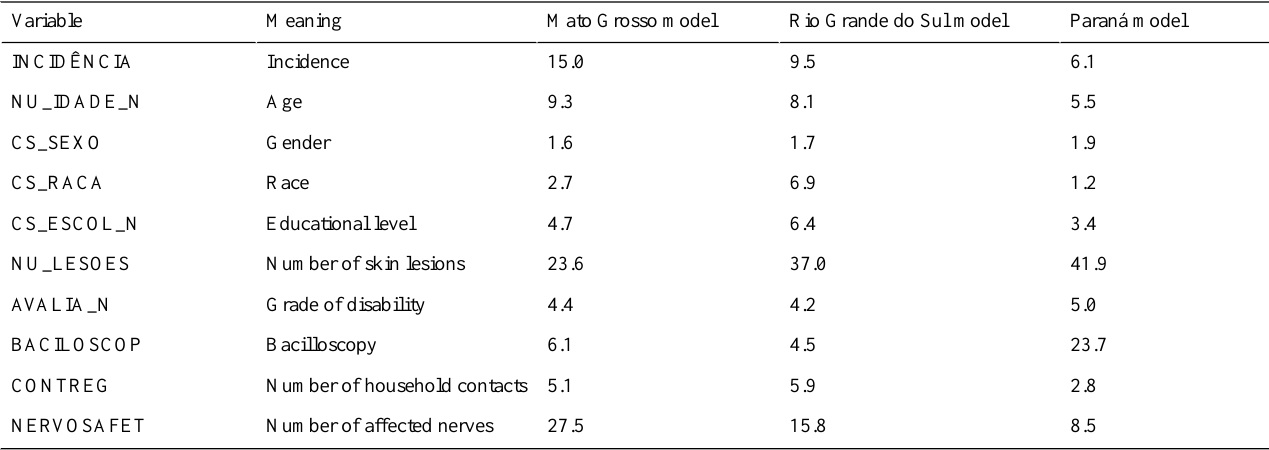
Table 3. Importance (in percent) of each variable utilized in the models that represent the highest